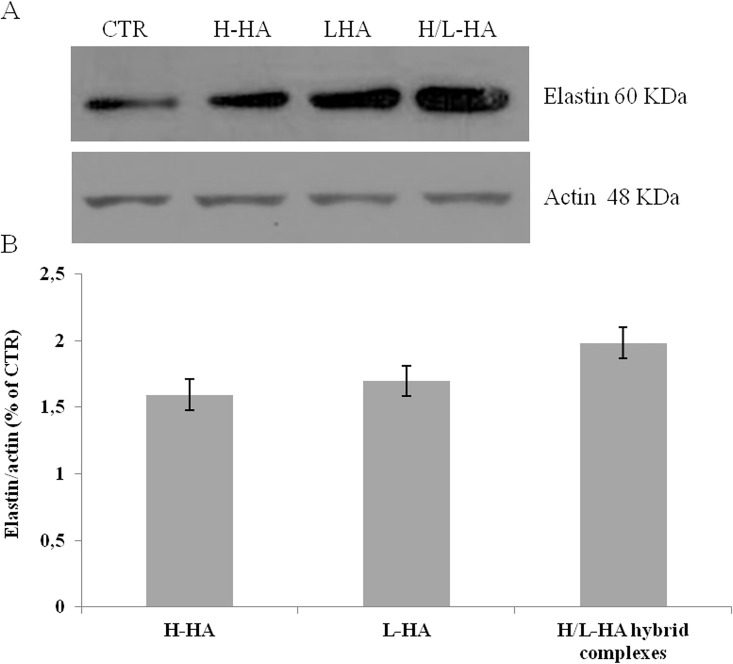
Western blot analysis of Elastin and Actin housekeeping protein levels in H-HA, L-HA and H/L-HA hybrid complexes treated samples, after 7 days of treatment, compared to the control.(A) Specific bands, corresponding to the proteins of interest are measured using commercially available software (Image J software). (B) Densitometry was reported as mean of two different experiments performed in duplicate.